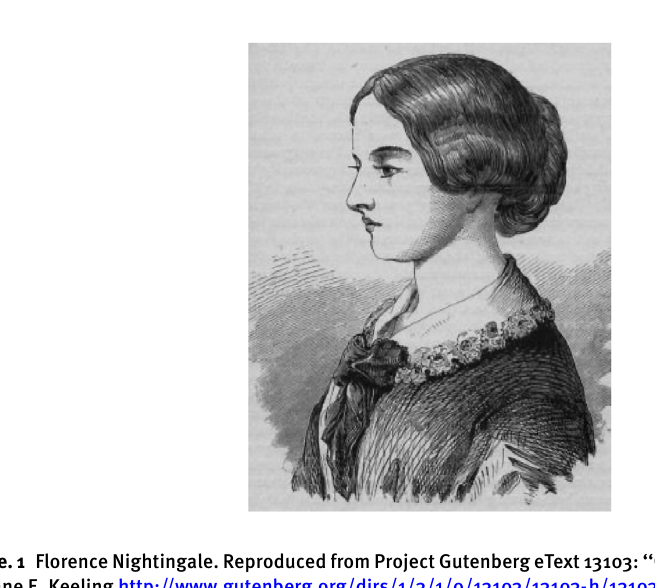
Figure.1 FlorenceNightingale.ReproducedfromProjectGutenbergeText13103:‘‘GreatBritainandHerQueen’’, by Anne E. Keeling http://www.gutenberg.org/dirs/1/3/1/0/13103/13103-h/13103-h.htm. hospital mortality, length of ITU stay, and technical difficulty. The complexity score was based on subjective probability and established by a panel of over 50 experts from 23